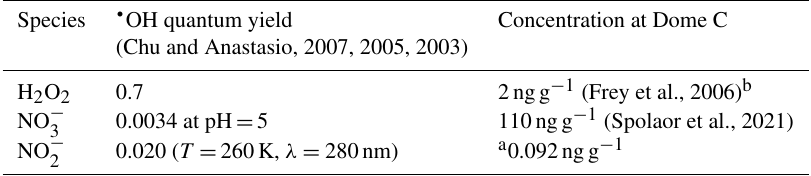
a Estimated (more details in the text). b The value is reported from 3.5m